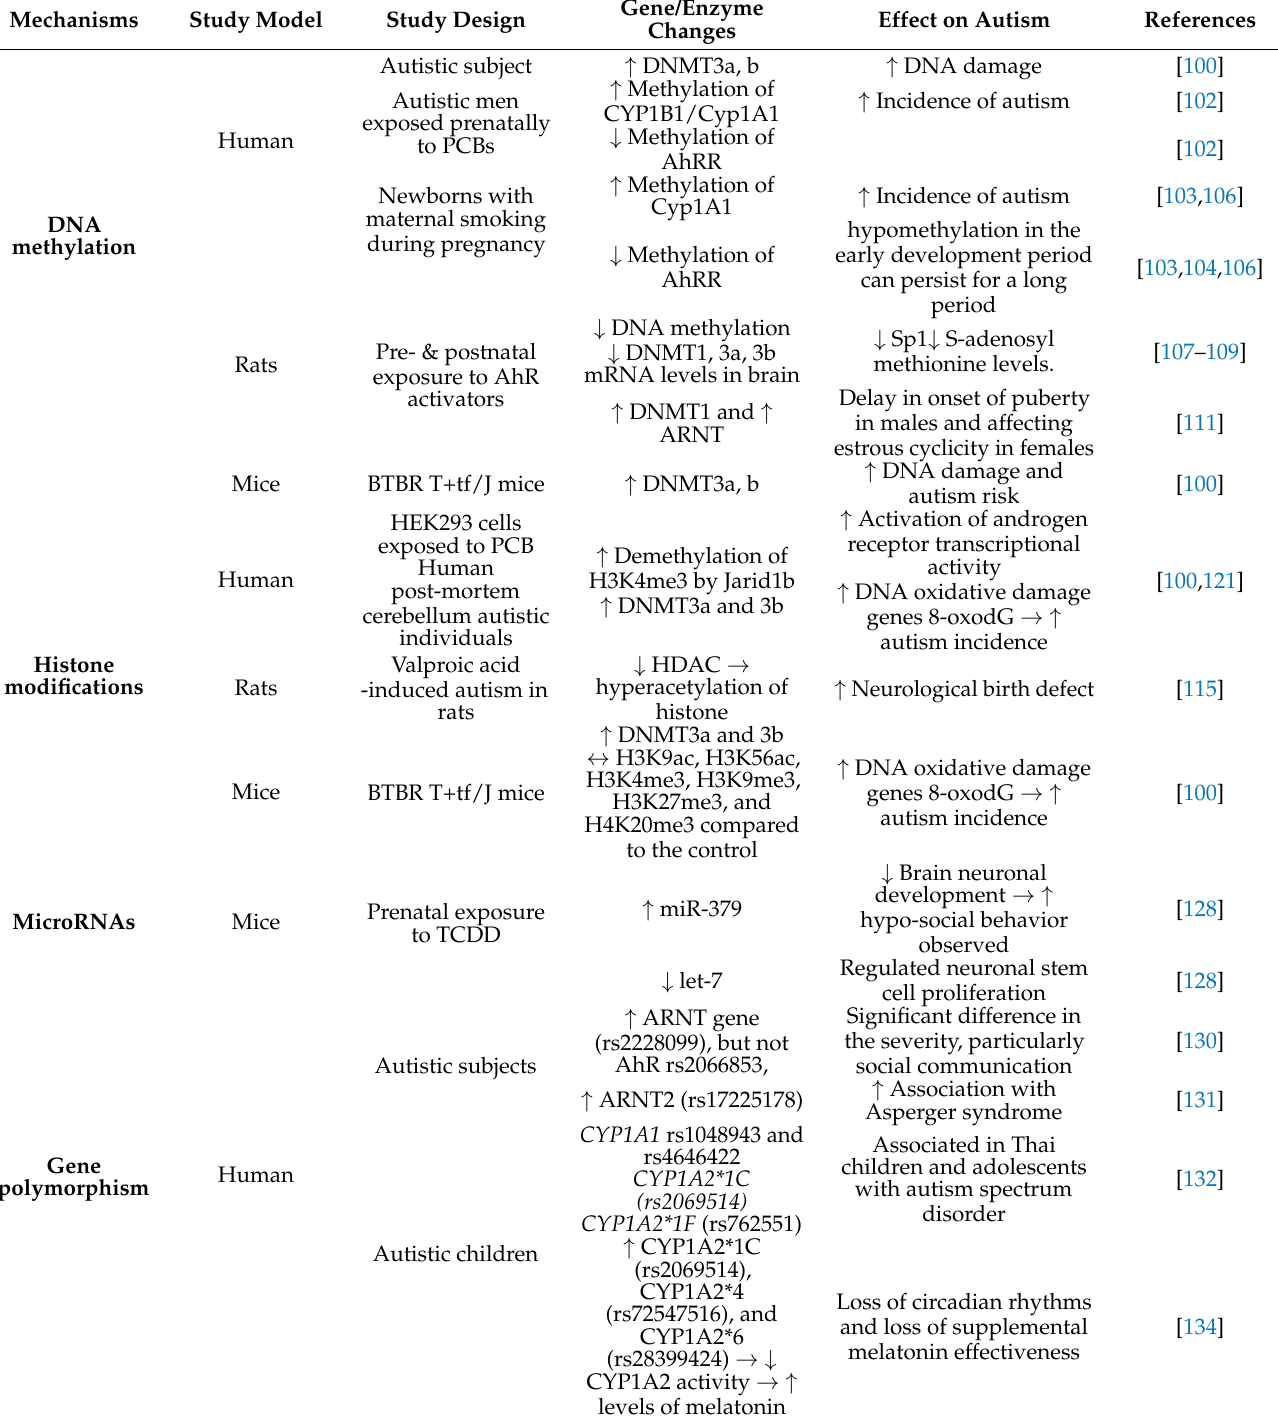
Table 2. Impact of epigenetic and polymorphic changes by AhR/CYP1 on